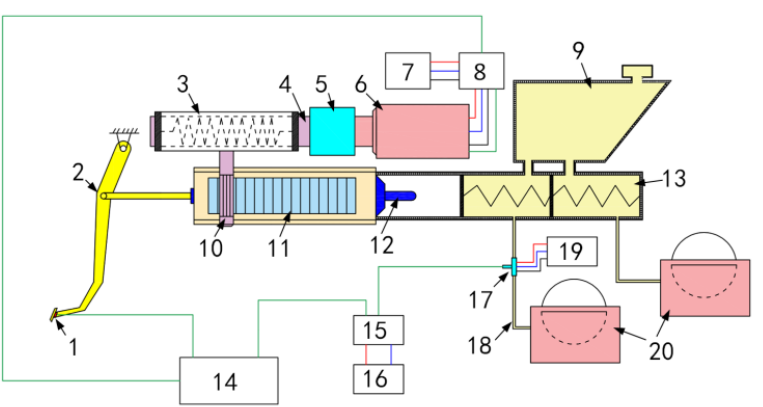
Figure 18. Composition of target oil pressure following control test bench: 1. WT901CM attitude sensor, 2. brake pedal, 3. worm wheel, 4. worm, 5. coupling, 6. servo motor, 7. DC power supply, 8. motor driver, 9. oil cup, 10. spline shaft, 11. rack, 12. master cylinder push rod, 13. master cylinder, 14. PC Software, 15. NI acquisition card, 16. NI acquisition card chassis, 17. oil pressure sensor, 18. oil pipe, 19. DC power supply, 20. brake caliper.